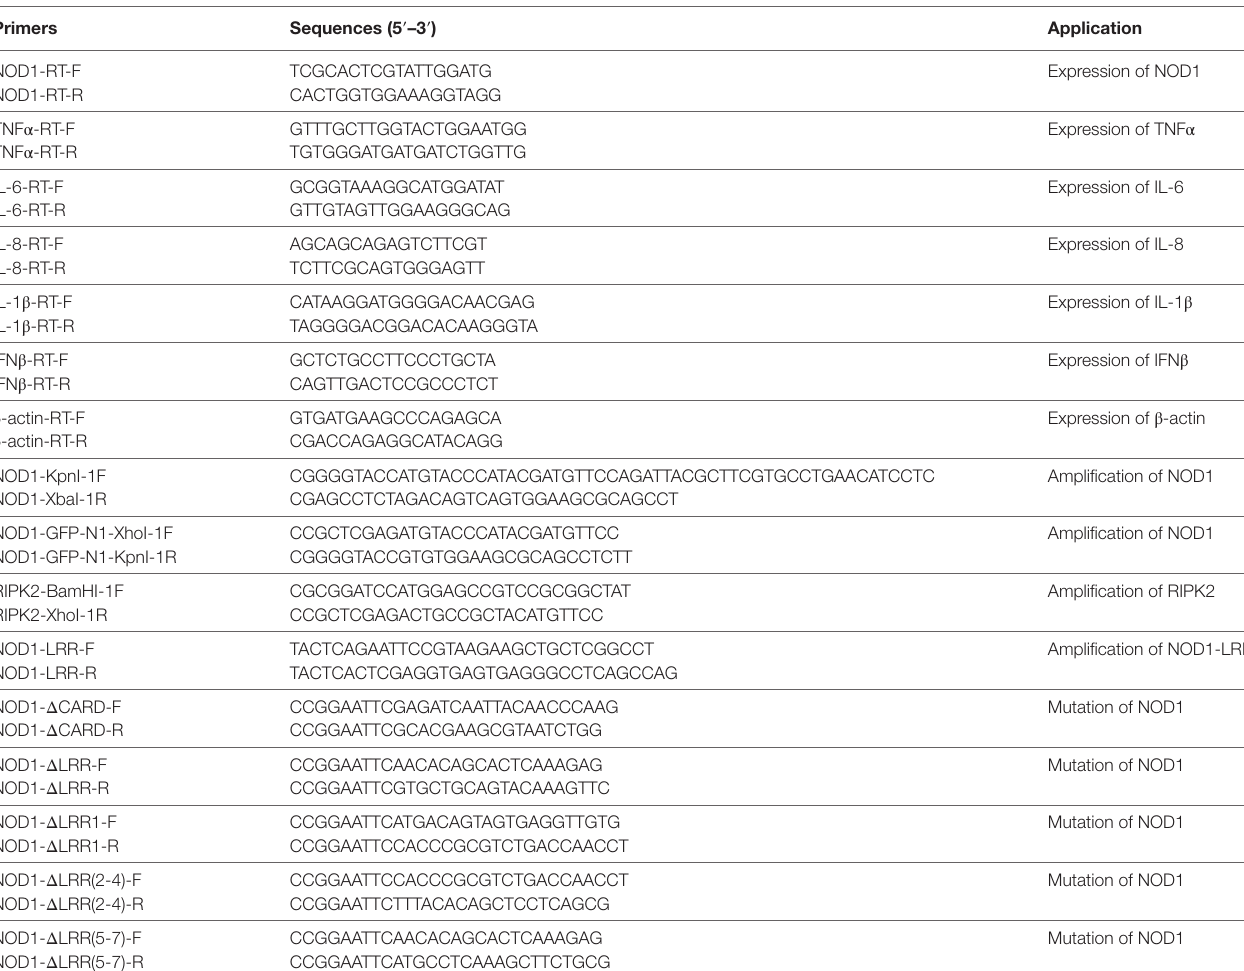
TaBle 1 | PCR primer sequence